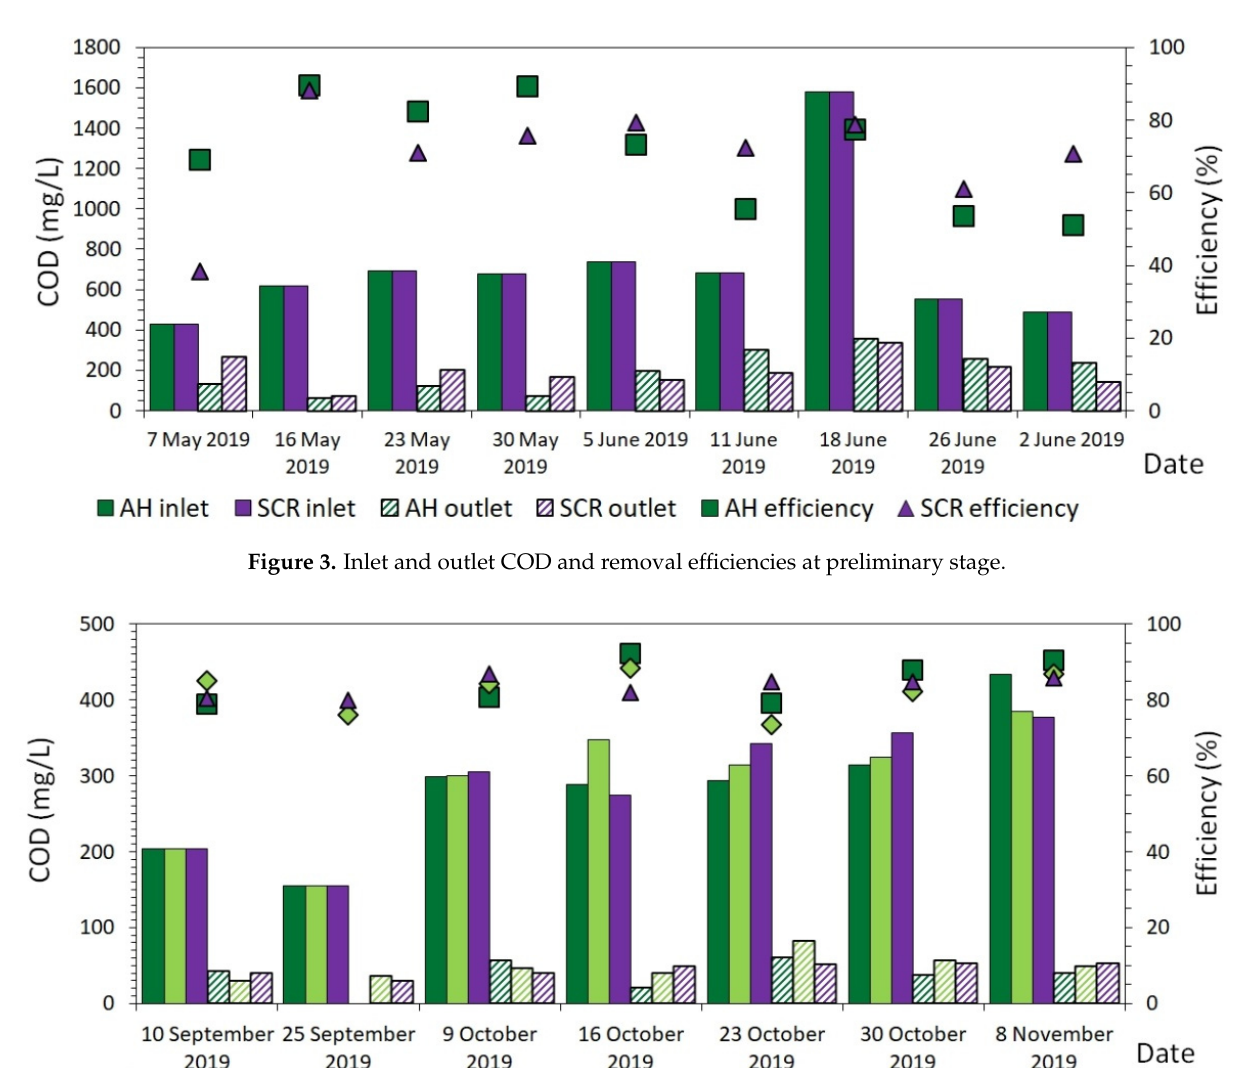
Table 2. Inlet and outlet COD and removal efficiencies at stage I.